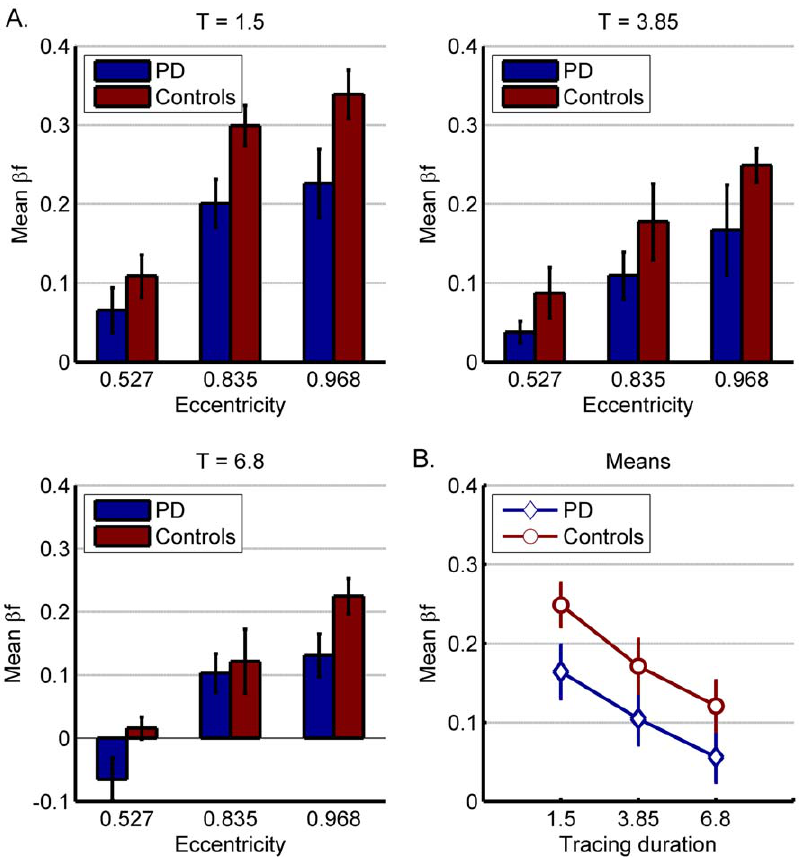
Figure 3. Mean b f values chosen by PD patients and controls for each of the three tracing-durations (A) and across the effect of eccentricity (B). Error bars denote SE.